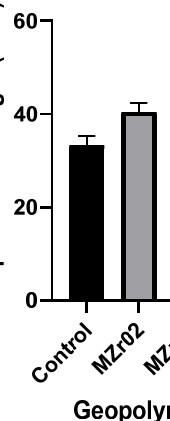
Figure 3. The FTIR spectra of starting materials and geopolymer samples.